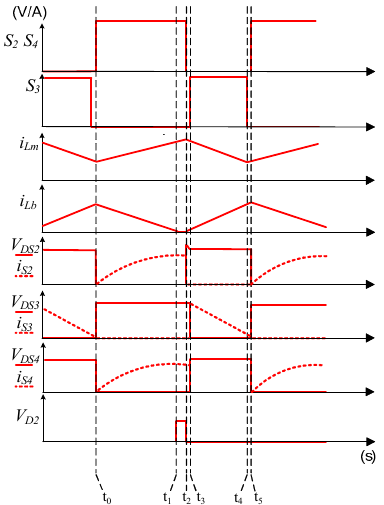
Figure 3. Stage 1 waveform diagram of the main component operation.